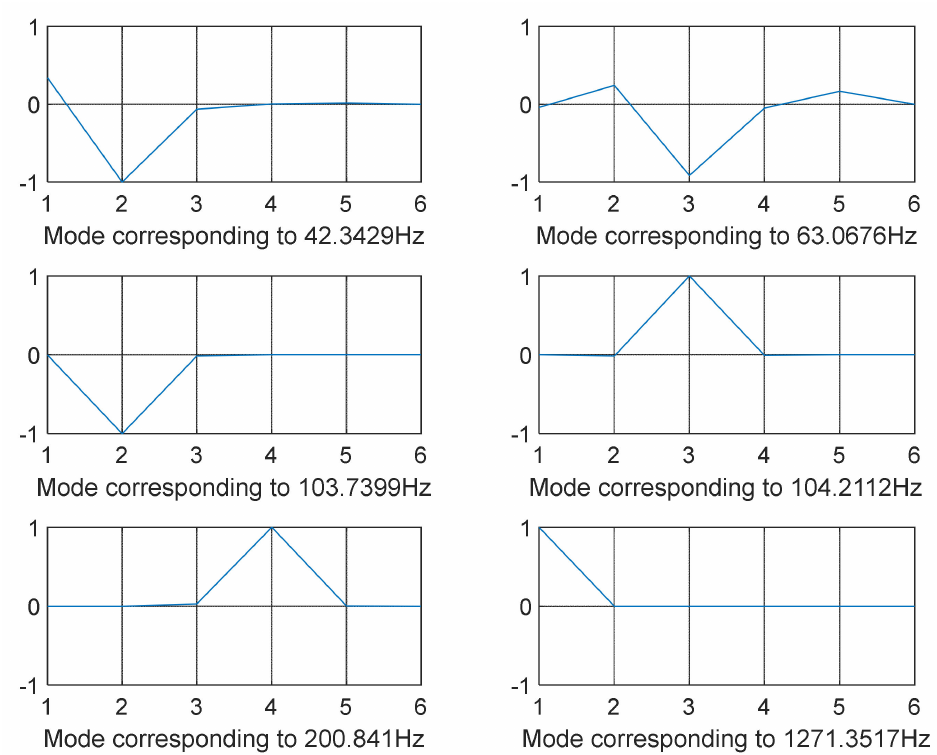
Figure 6. GA-optimized mode shapes 7–12 (12-DOF model—shaking loads only).